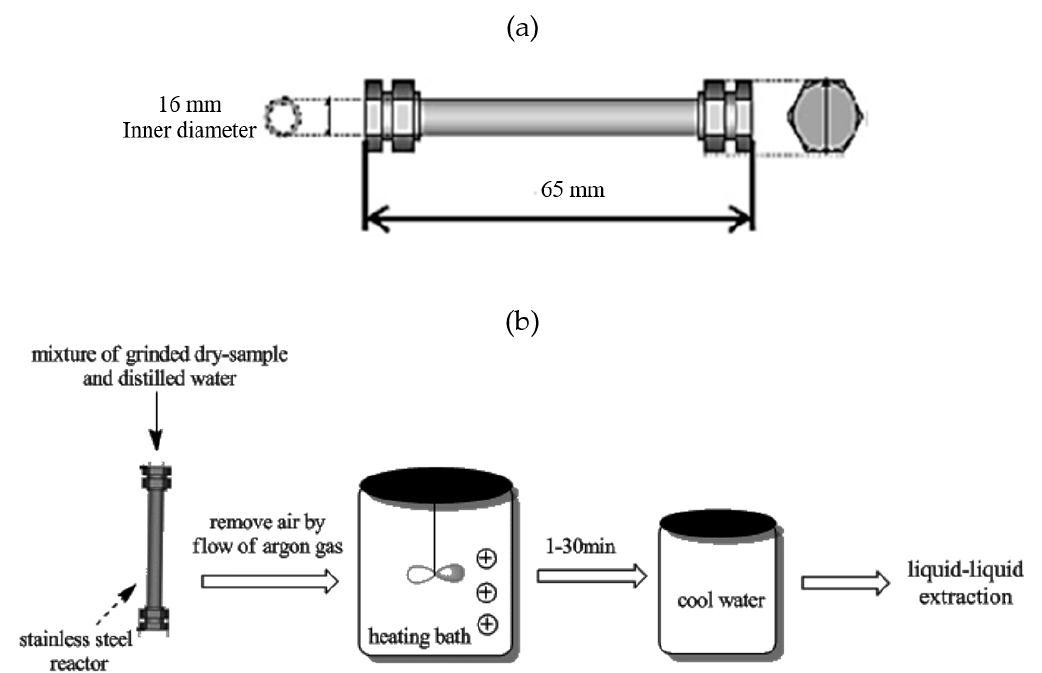
Figure 1. Extraction of essential oil from Aquilaria malaccensis by the subcritical water method: ( a ) stainless steel reactor; ( b ) subcritical water process and product recovery steps depiction.